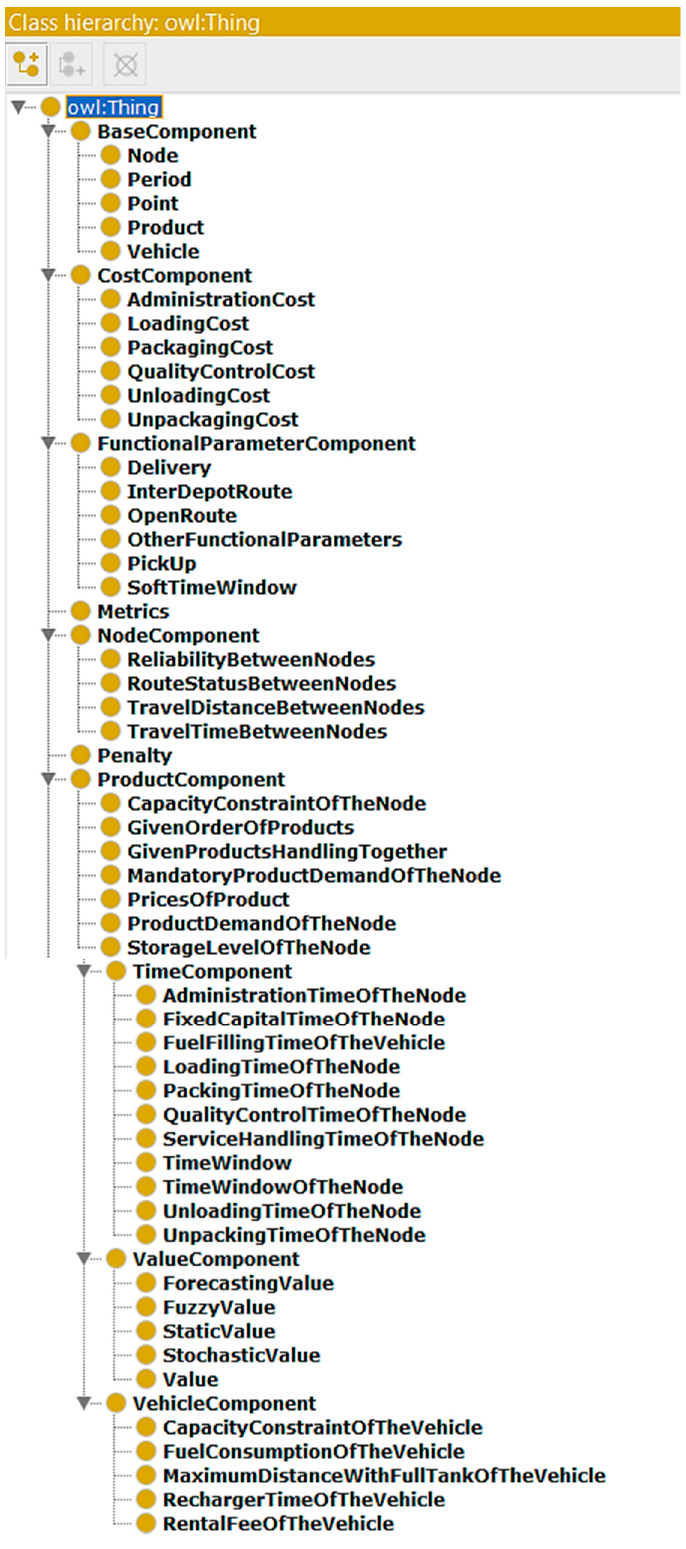
Figure A2. The ontology class hierarchy.